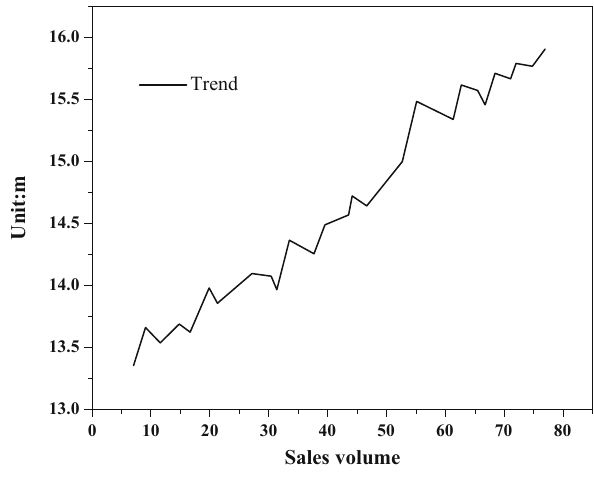
Figure 5: TC scatter plot of monthly cigarette sales.